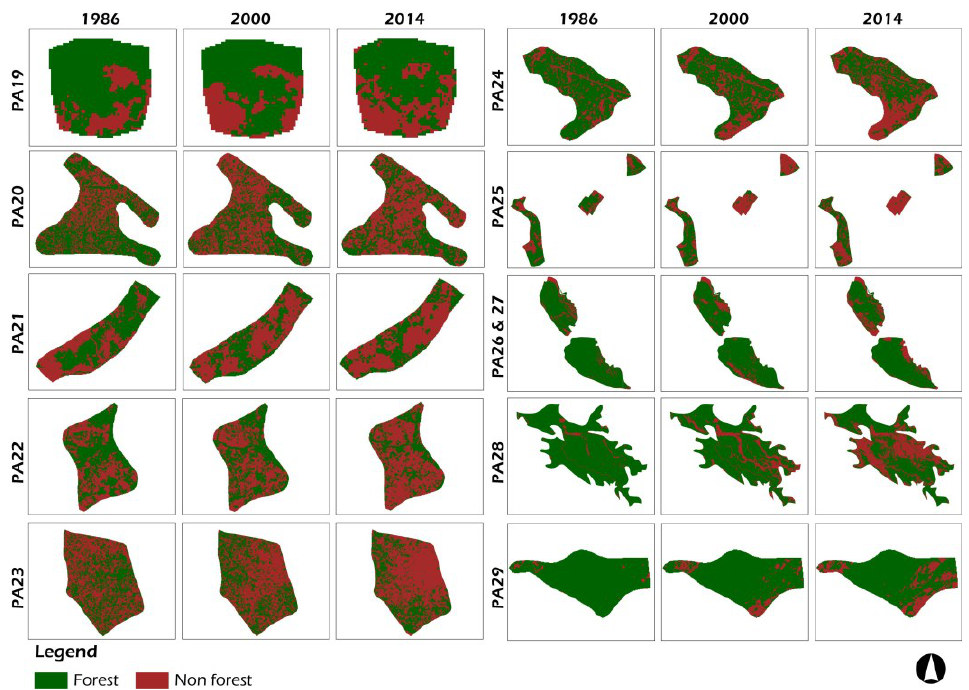
Figure 4. Forest and non-forest maps of protected areas in Delta state for 1986, 2000 and 2014.